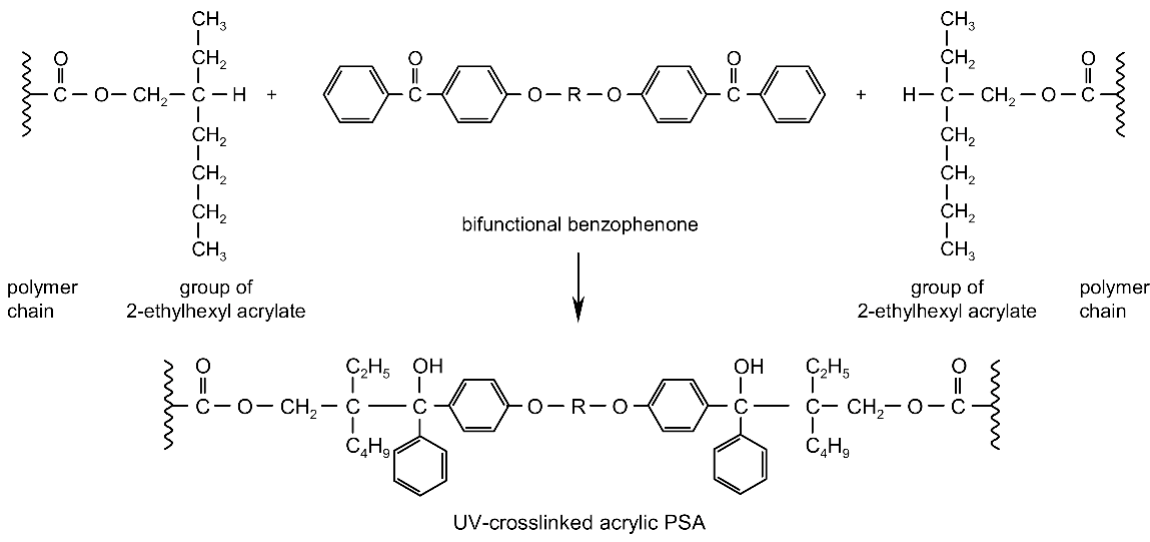
Figure 1. UV ‐ initiated crosslinking reaction of PSA with multifunctional benzophenones (R = organic group).